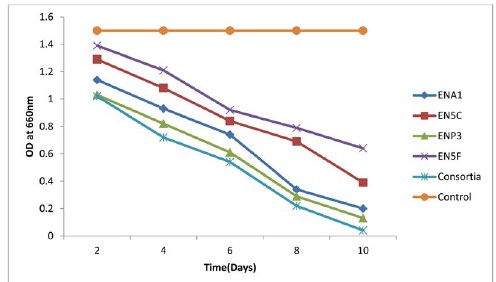
Fig. 5. Degradation potential of individual isolates and consortium with NPK for